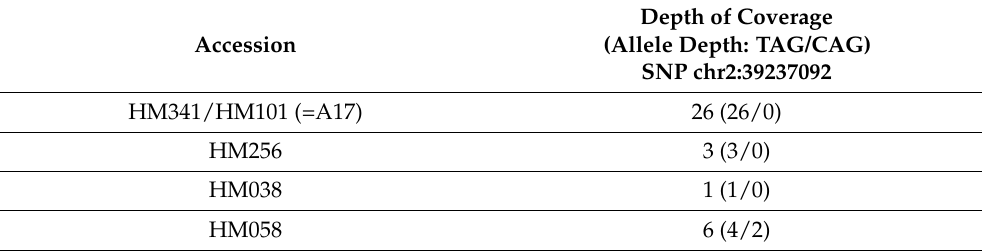
Table 1. M. truncatula accessions bearing the premature stop codon in the MtCLE34 gene and the depth of coverage of